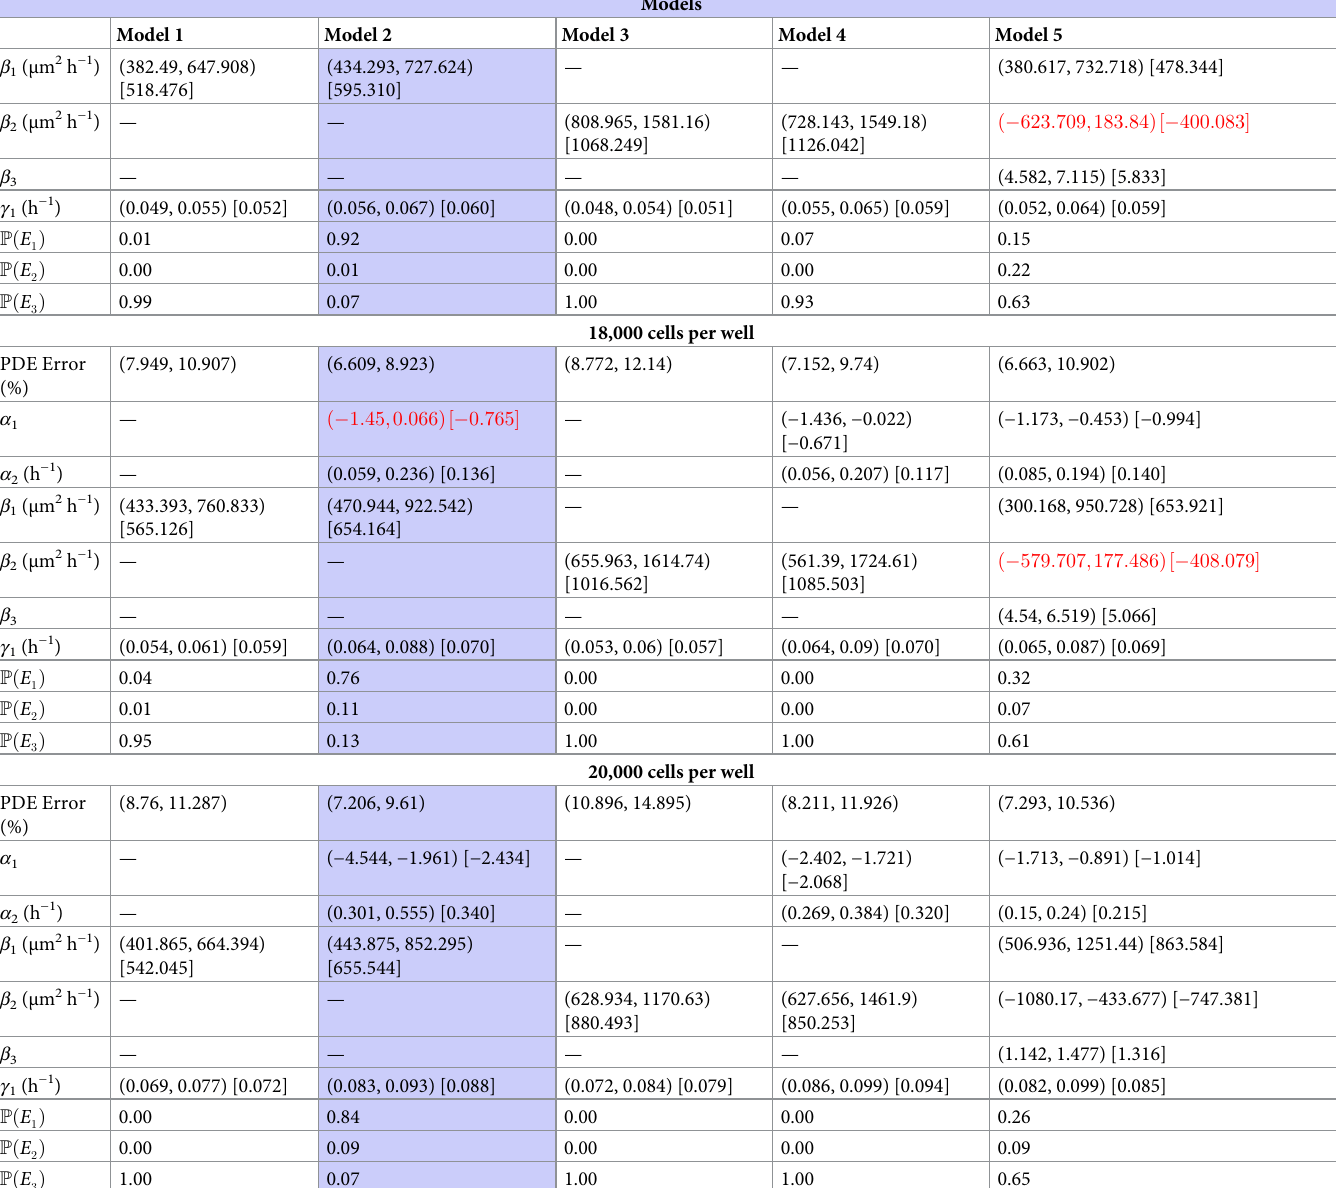
Interval estimates, PDE errors, and model selection results for the models in (3)–(6) when applied to the each data set from Jin et al. [13]. The numbers in square brackets give the modes from the kernel density estimates of the corresponding bootstrap sample for the corresponding parameter. The PDE errors are computed using sampled initial conditions. Significance levels for all confidence intervals are 95%. The blue column for each data set highlights the optimal model, and the red text indicates confidence intervals that contain